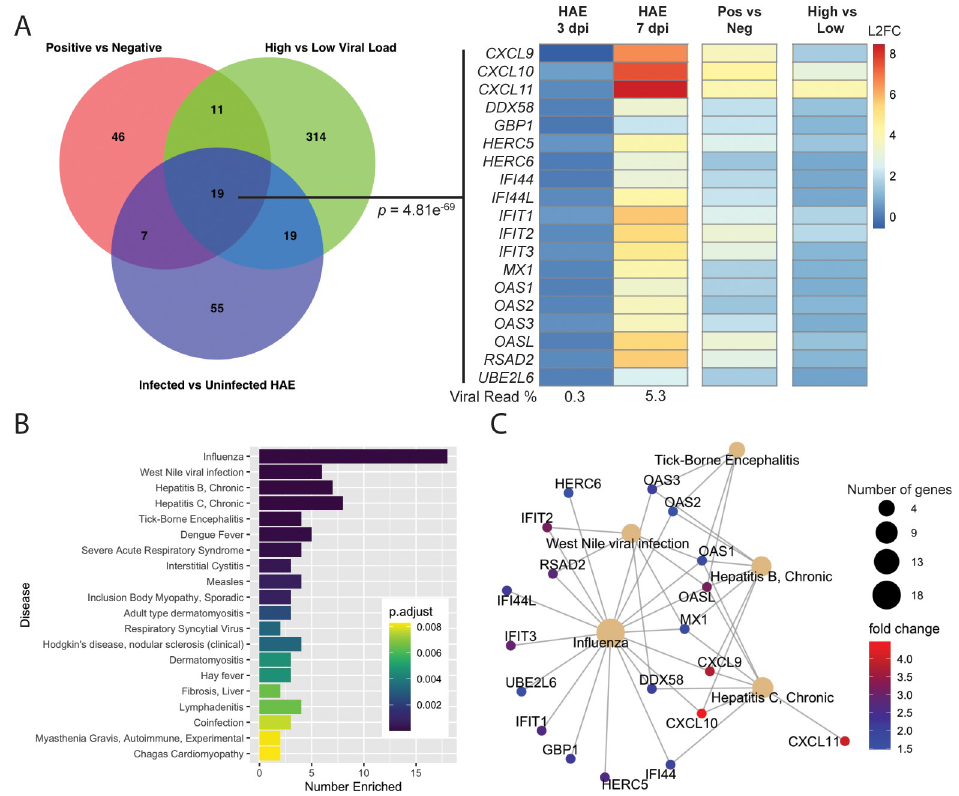
Fig 3. Consensus genes induced upon SARS-CoV-2 expression. (A) Venn diagram of DE genes in SARS-CoV- 2-positive versus -negative, high versus low viral load, and top 100 genes with the highest absolute log2 fold change in infected versus uninfected HAE. Consensus set of 19 genes (SuperExact Test, p = 4.81 × 10 − 69 ) DE in all 3 analyses are shown, with log2 fold change values relative to uninfected HAE (for day 3 and day 7 post infection), SARS-CoV- 2-negative NP swabs (for SARS-CoV-2-positive NP swabs), or low viral load (for high SARS-CoV-2 viral load samples). SARS-CoV-2 reads at day 3 and 7 post infection were 0.3% and 5.3%, respectively. (B) Top 20 DisGeNET terms for which SARS-CoV-2 cell-intrinsic antiviral response consensus genes are overrepresented. “Number Enriched” is the number of SARS-CoV-2 consensus genes that belong to each disease term. (C) Interaction network of SARS-CoV-2 consensus genes for top 5 most similar diseases identified in panel B. Size of disease node represents the number of genes enriched, and fold change is the log2 fold change seen in SARS-CoV-2-positive versus -negative NP swabs. Raw data available in the GEO Repository, accession GSE154768 (HAE samples) or GSE152075 (NP swabs). DE, differentially expressed; GEO, Gene Expression Omnibus; HAE, human airway epithelial cells; NP, nasopharyngeal; SARS-CoV-2, severe acute respiratory syndrome coronavirus 2.